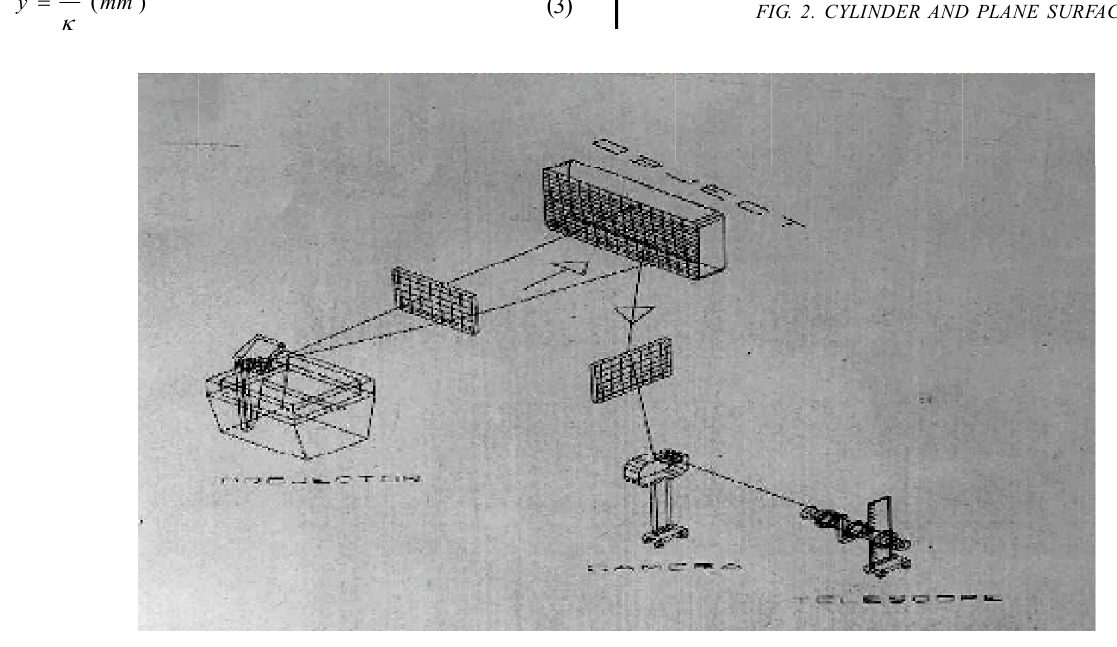
FIG. 1. SETUP OF RASTER STEREOGRAPHY